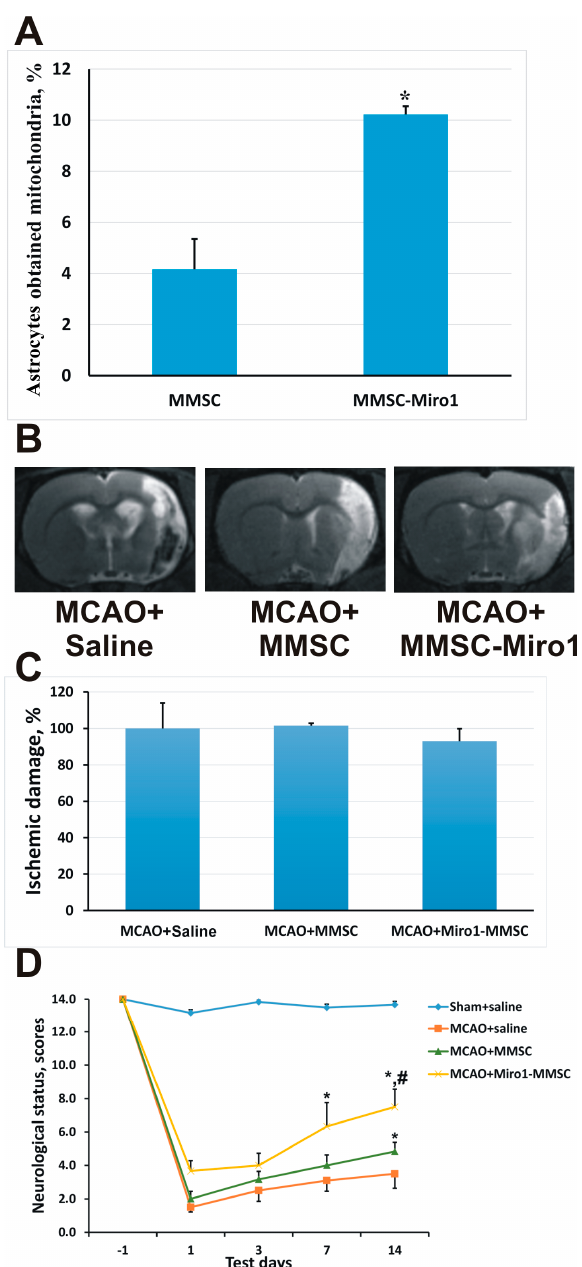
Figure 4. Beneficial effects of Miro1 overexpression on mitochondrial transfer. ( A ) Efficacy of mitochondrial transfer from MMSC overexpressing Miro1 to astrocytes after 24 h of co-cultivation; ( B ) Representative T2-weighted MR-images from coronal brain sections obtained 14 days after middle cerebral artery occlusion (MCAO). Hyperintensive regions refer to ischemic areas; ( C ) The volume of the ischemic lesions in the brain on day 14 after MCAO; ( D ) Effect of MMSC transplantation on the neurological status at different times after stroke. Intravenous injection with either native MMSCs or MMSC-Miro1 caused a significant decrease of the neurological deficit, with MMSC-Miro1 being more effective. *, p < 0.05 vs. ischemic saline controls; #, p < 0.05 vs. ischemic MMSC-treated rats. All cell culture experiments were performed at least in triplicate, and at least six animals were used for each group in the stroke study.